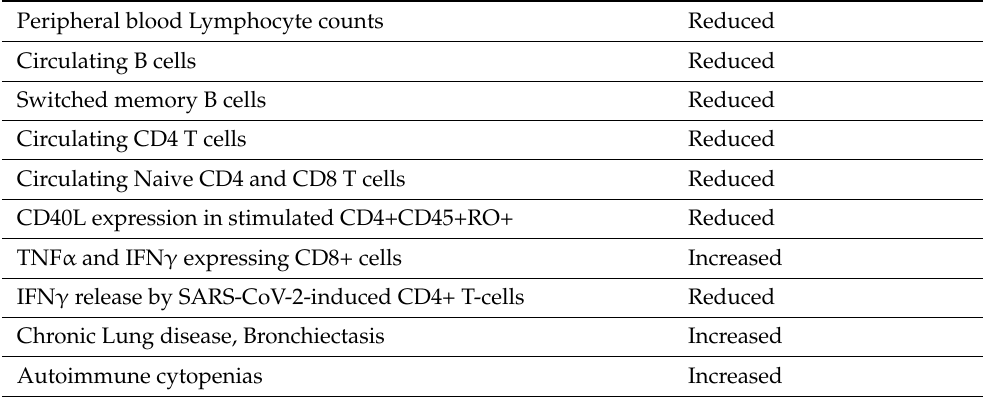
Table 3. Summary of immune alterations and clinical conditions relevant to the lack of antibody response to SARS-CoV-2 immunization in